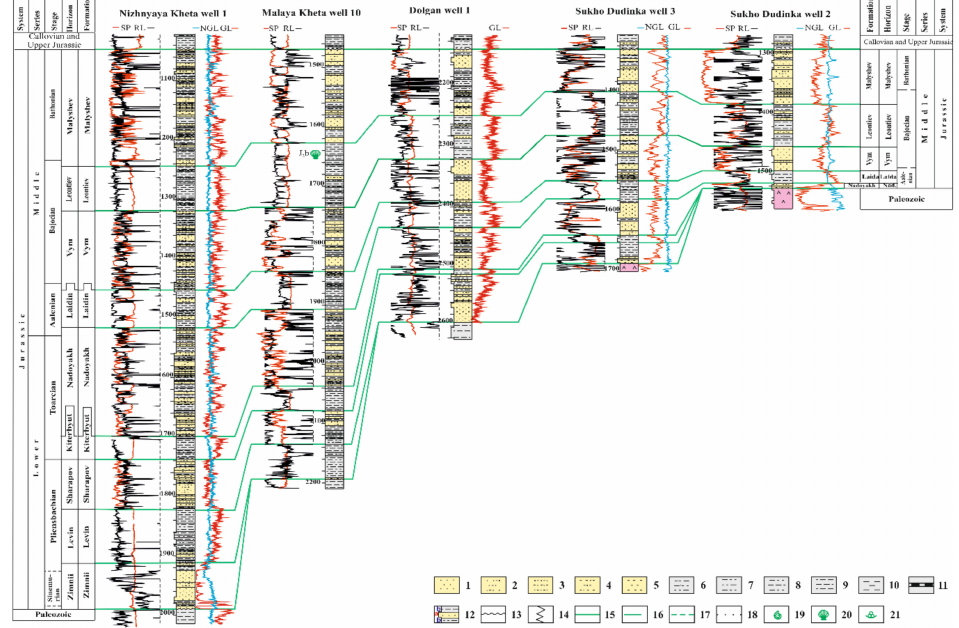
Figure 13. Correlation scheme of Lower and Middle Jurassic deposits in the south-western part of the Yenisei-Khatanga basin between the Sukho Dudinka and Nizhnyaya Kheta fields by G.G. Shemin and N.N. Kostagacheva. Location of the scheme line is shown in Figure 4. 1—sandstone, 2—silty